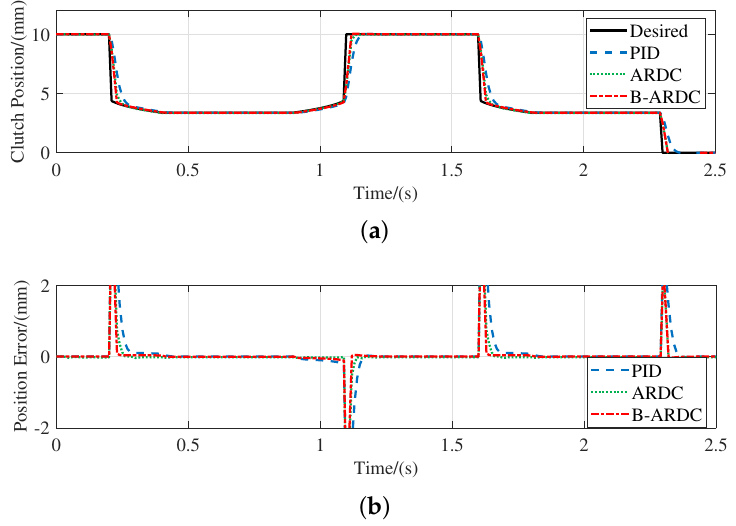
Figure 14. Performance comparison of position loop controllers under the first simulation condition: ( a ) Clutch Position; ( b ) Position